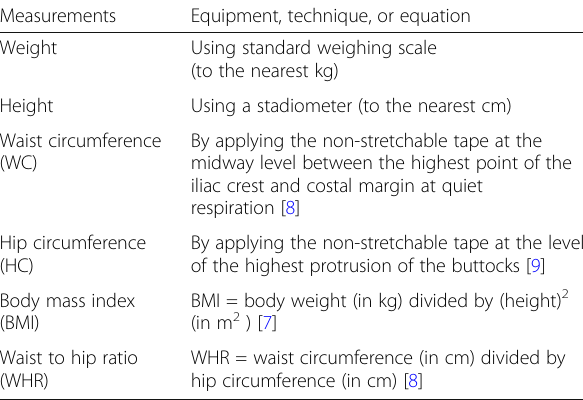
Table 1 Anthropometric variables and derived values in the present study: technique of measurements or equation